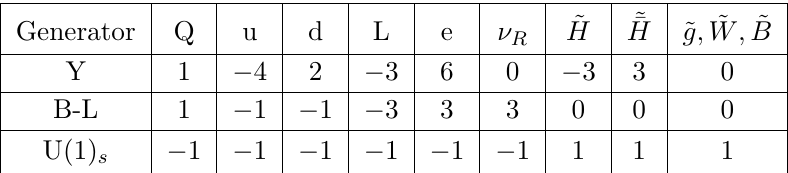
Table 1 . Some fermion U(1) q-charges considered in the text. The line in the bottom is the R-symmetry of the MSSM and the corresponding sfermions have charge q +